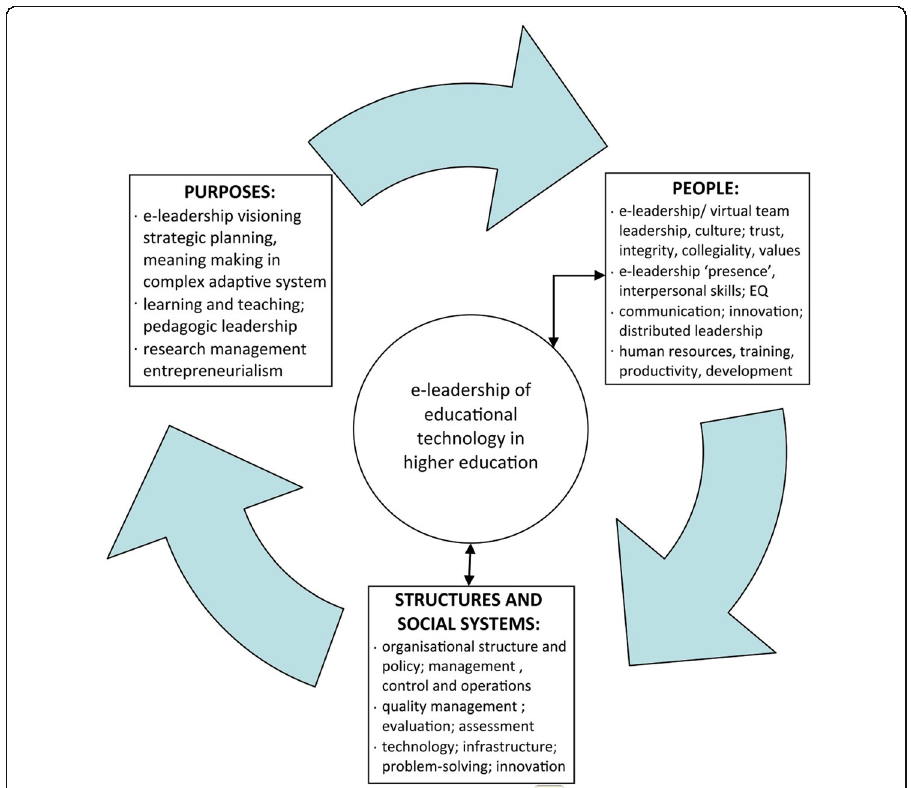
Fig. 2 e-Leadership framework for educational technology in higher education (Jameson, 2013, p.